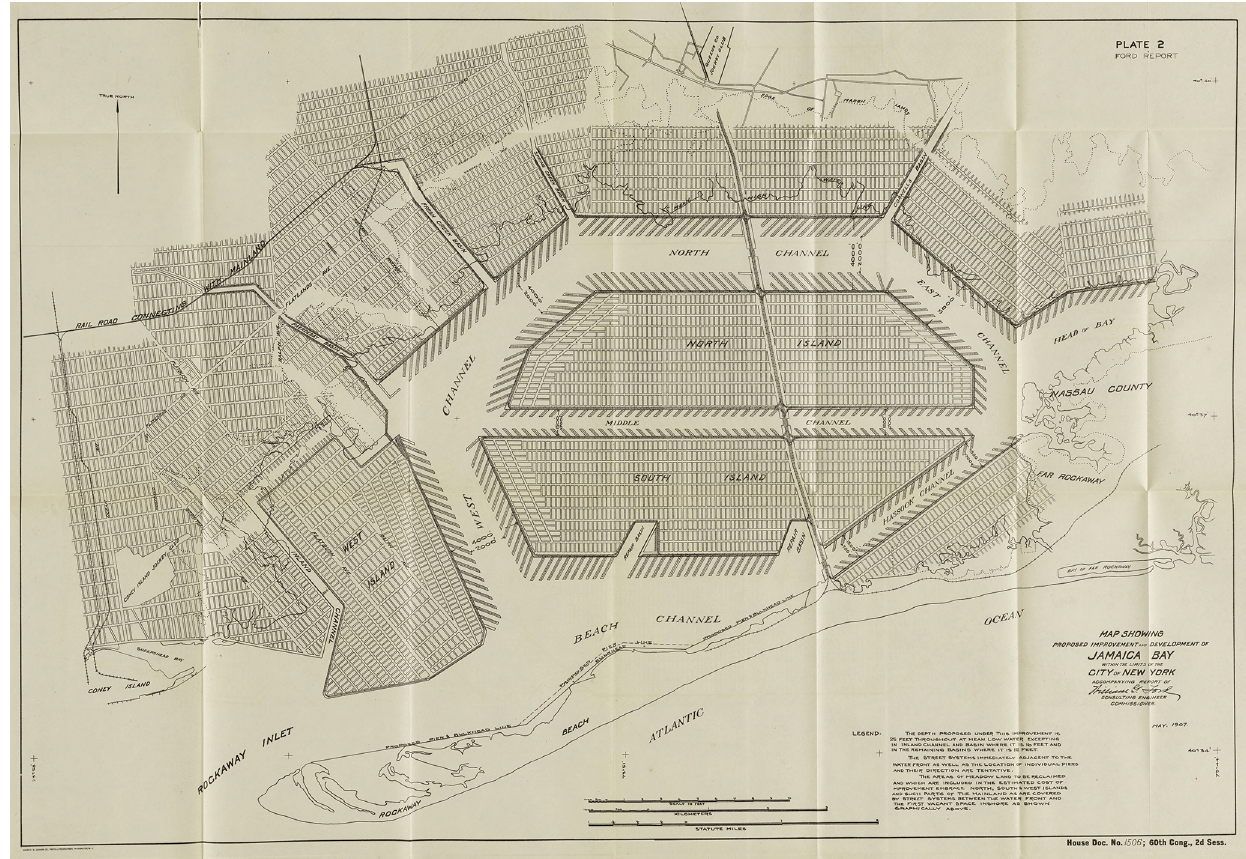
Figure 2. Plan for converting Jamaica Bay into a port (Jamaica Bay Improvement Commission,